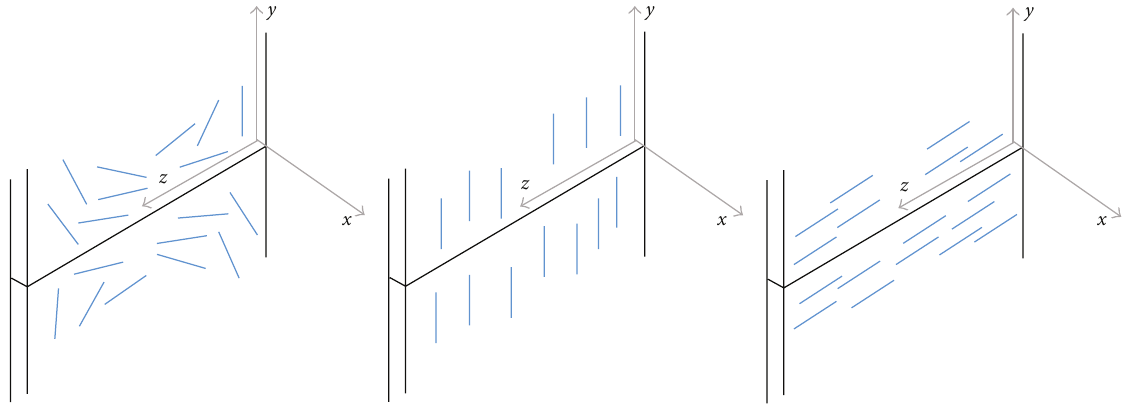
Figure 6: Schematic representation of welding samples with different fiber